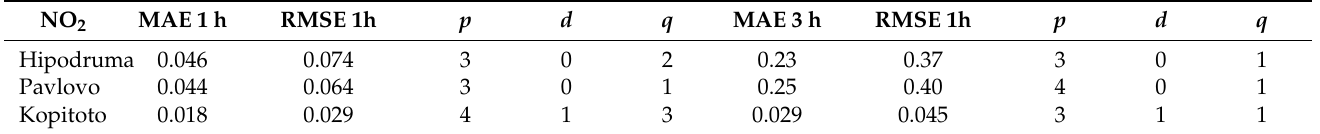
Table 11. Mean absolute error of CO for the chosen parameters p, d, q, for 1 h and 3 h